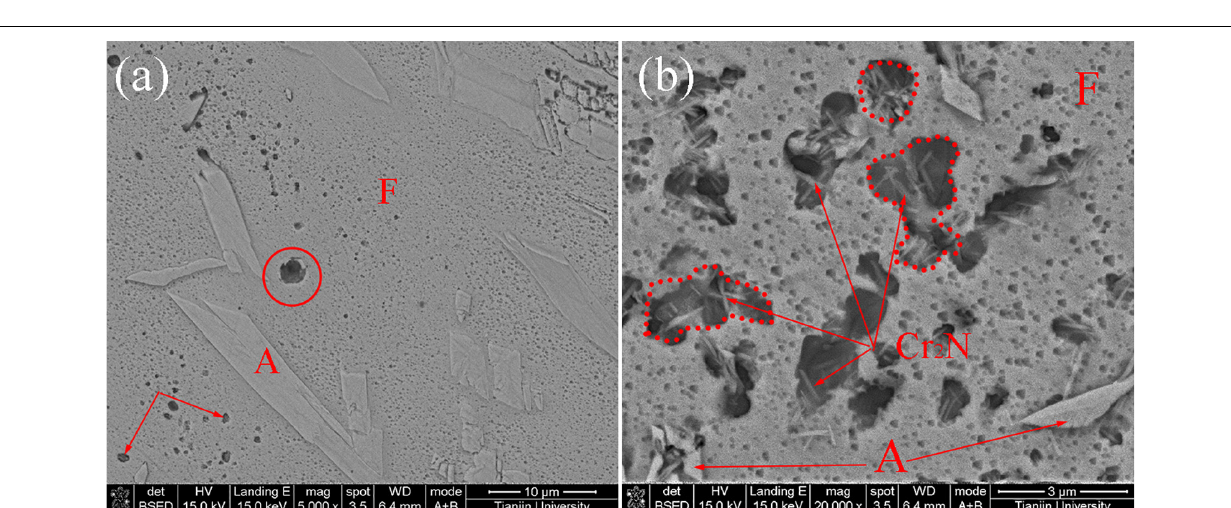
Frontiers in Materials |